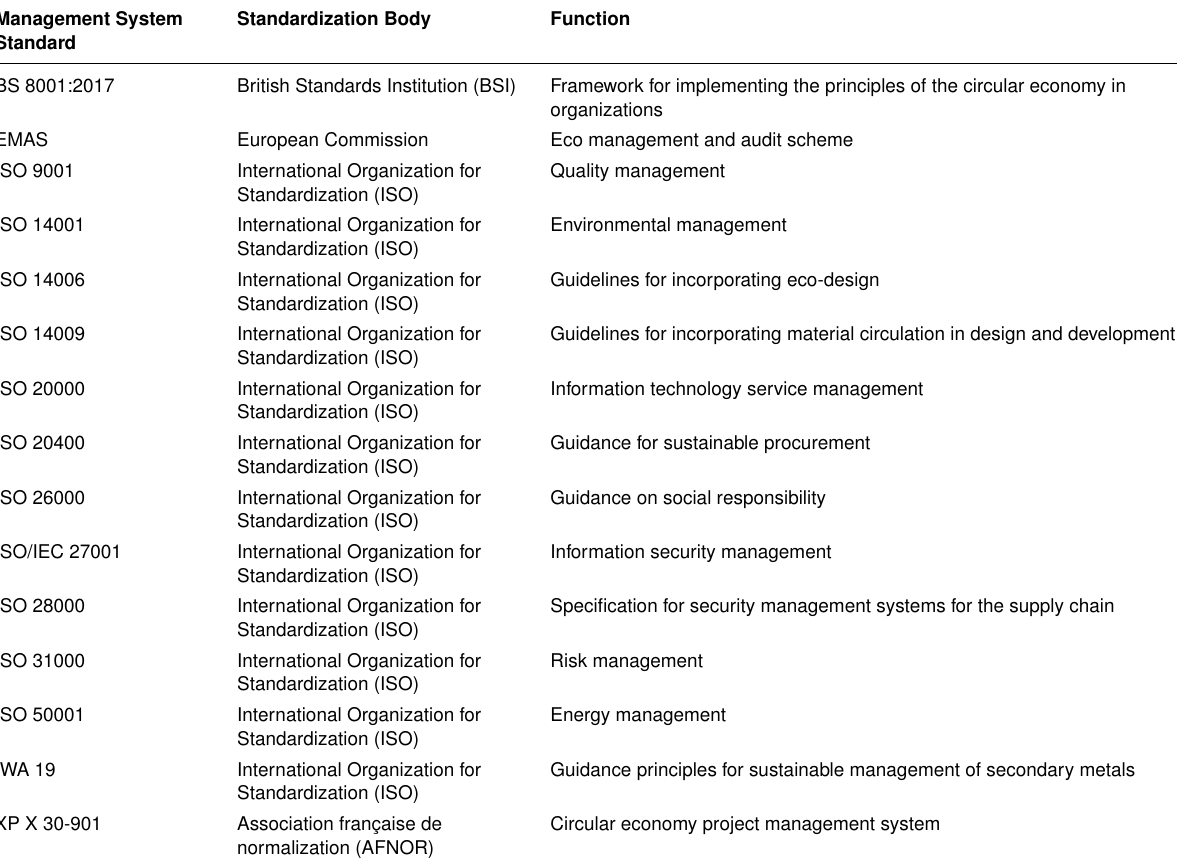
Table A1. Appendix